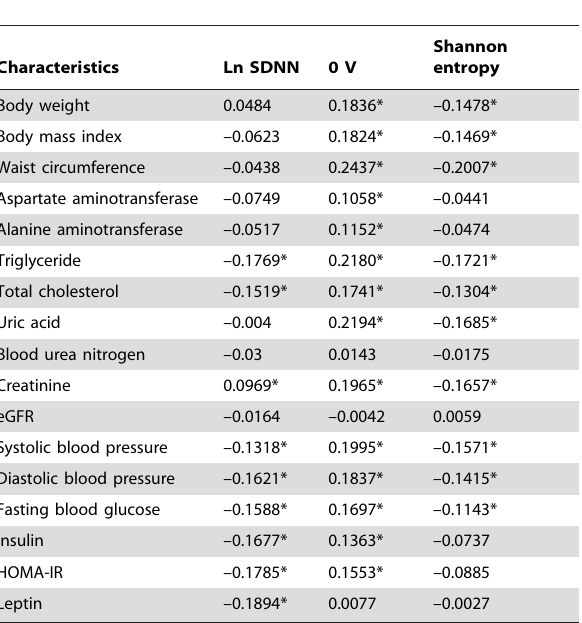
Table 3. Pearson’s correlations coefficient between HRV indices and metabolic parameters.